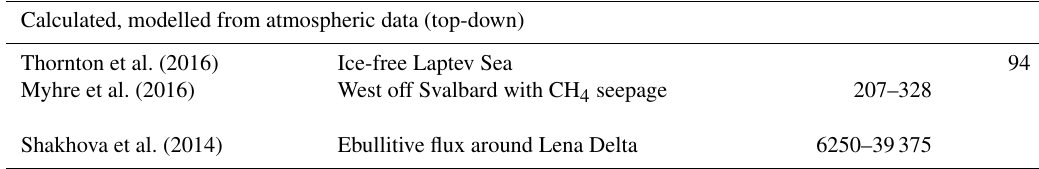
Calculated, modelled from atmospheric data